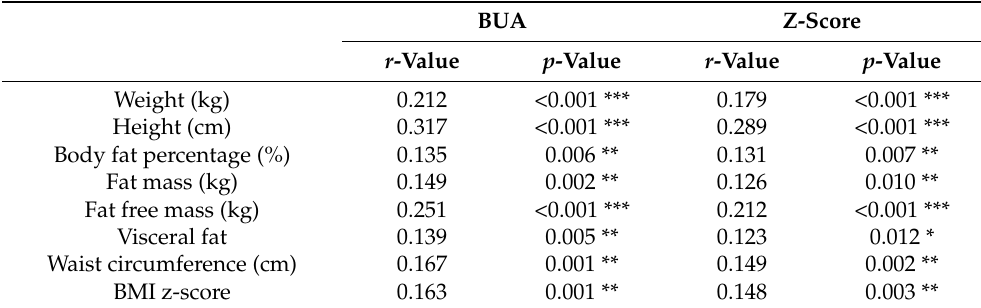
Table 3. Unadjusted correlations of body composition variables with bone outcome variables in schoolchildren ( n = 415).